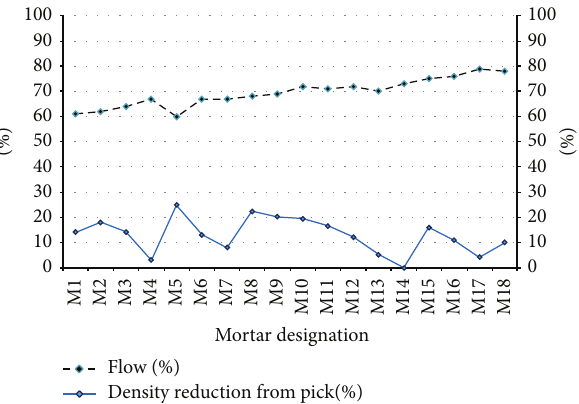
Figure 11: Density (kg/m 3 ) reduction for all mixes from the peak of density and the percentage of flow of